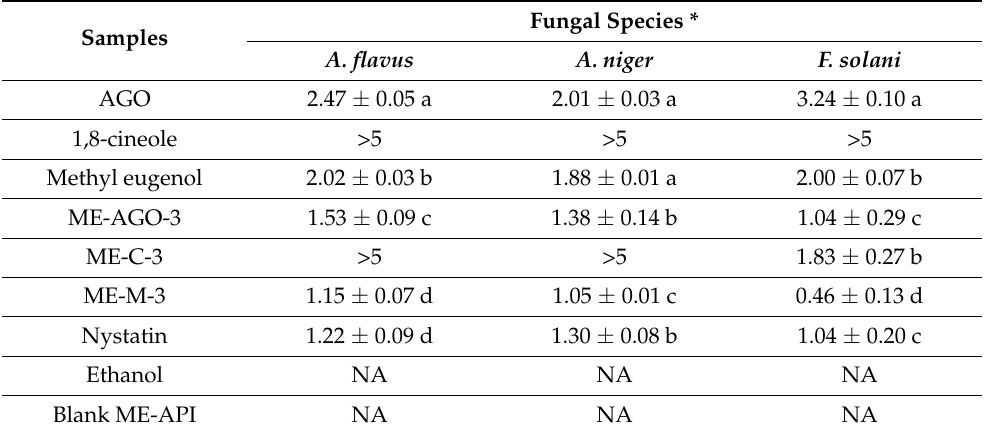
Table 4. IC 50 values ( µ g/mL) of 30% w / w AGO in ethanol, 30% w / w 1,8-cineole in ethanol, 30% w / w methyl eugenol in ethanol, and their ME formulation ( n = 3).